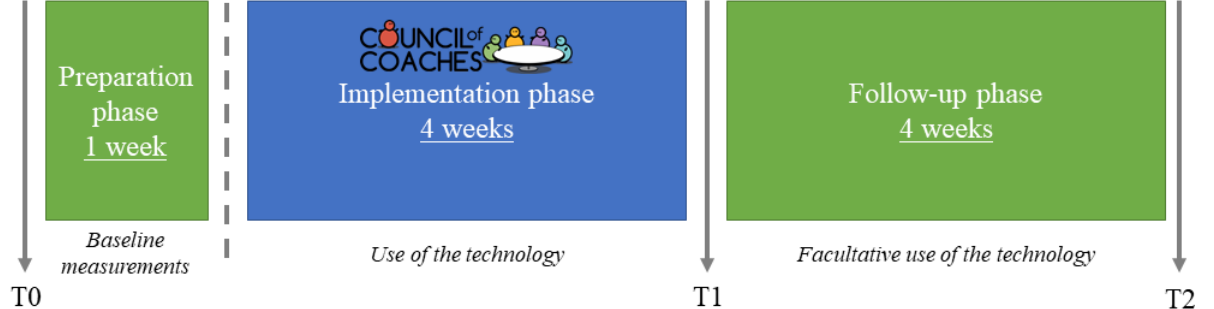
Figure 1. Study procedures for the first and second rounds of this 9-week observational study with a pretest-posttest design.